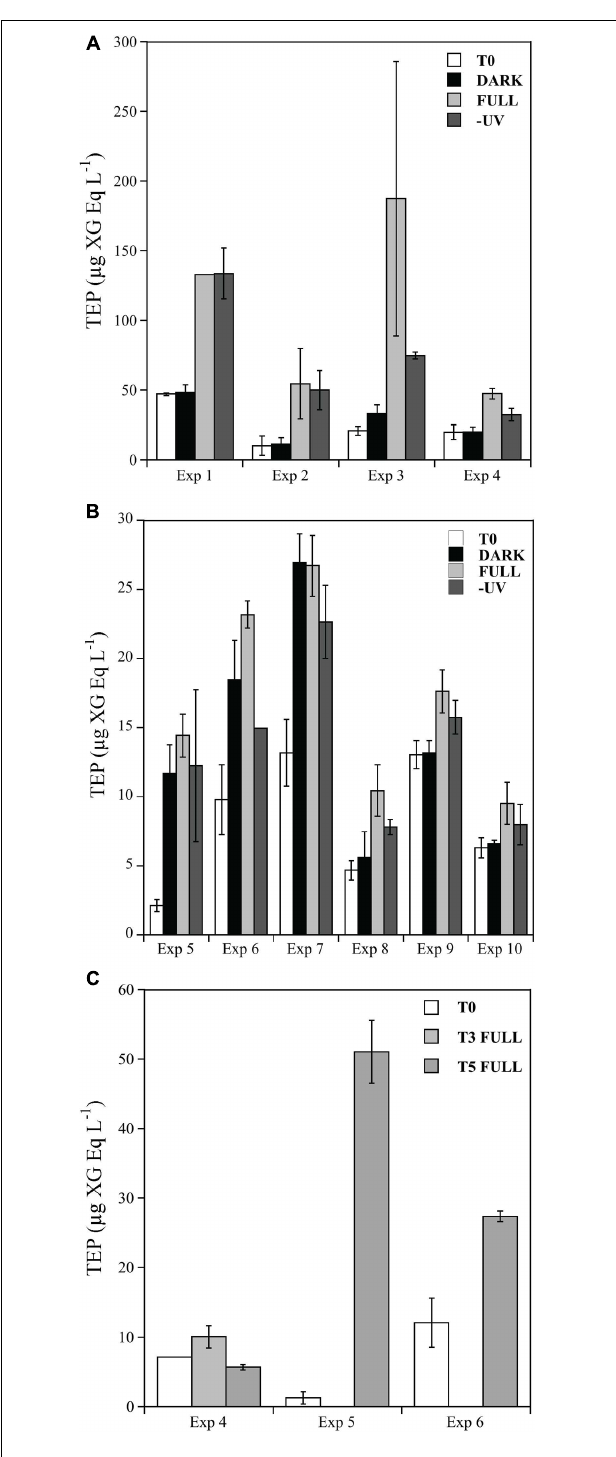
FIGURE 2 | Changes in TEP concentrations ( µ g XG Eq. L − 1 ) over incubation time for initial time (white bars), DARK (black bars), -UV (gray bars), and FULL (light gray bars) treatments during the four experiments performed in the Pacific Ocean (A) and the six experiments performed in the Atlantic Ocean (B) and in abiotic treatments (C) . Error bars represent standard errors of duplicates. Note that (A,B) have different y -axis